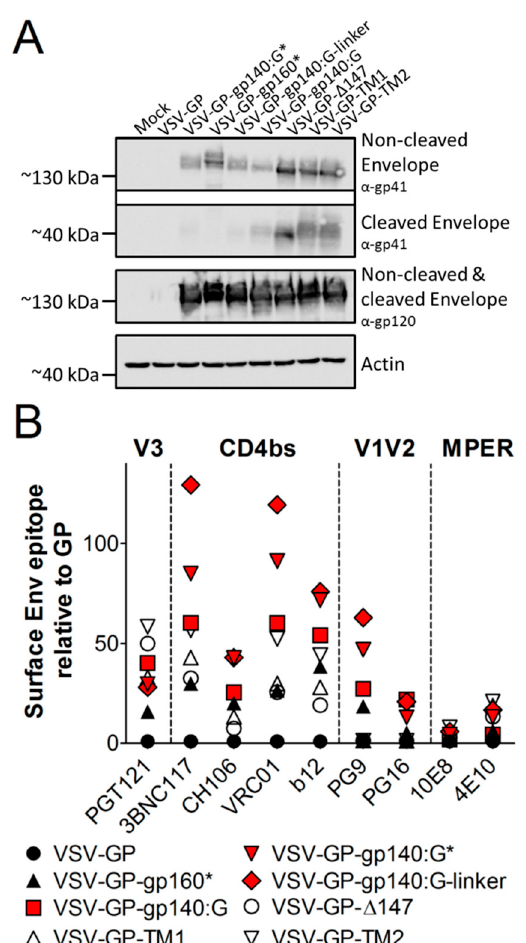
Figure 3. All HIV Env variants are expressed at comparable levels in infected BHK-21 cells. BHK-21 cells were infected with VSV-GP, VSV-GP-gp140:G*, VSV-GP-gp160*, VSV-GP-gp140:G-linker, VSV-GP-gp140:G, VSV-GP- ∆ 147, VSV-GP-TM1 and VSV-GP-TM2 with a MOI of 0.1. Twenty-four hours after infection, cell lysates were prepared for western blotting ( A ) or cells were trypsinized and analyzed by flow cytometry ( B ). As a negative control, cell lysates from non-infected BHK-21 cells (Mock) were used. ( A ) The non-cleaved HIV Env precursor protein (gp160) and the cleaved gp41 protein were detected with an anti-HIV-1 gp41 monoclonal antibody (4E10, upper two blots). The non-cleaved Env precursor and the cleaved gp120 subunit were detected on a separate membrane using an anti-HIV-1 gp120 monoclonal antibody (16H3, third blot). As a loading control, an anti-actin antibody was used (lower blot). ( B ) Cells were stained with HIV bnAbs against the V1V2 loop of gp120 (PG9, PG16), the V3 loop of gp120 (PGT121), the CD4 binding site (b12, VRC01, 3BNC117, CH106) or the MPER of gp41 (4E10) and fluorescently-labeled anti-human secondary antibodies. As a loading control, the LCMV-GP-specific WEN4 was used. The ratio of the geometric mean fluorescence of every single HIV-specific antibody relative to the geometric mean fluorescence of the LCMV-specific WEN4 was calculated. The graph shows the mean ratio of duplicate samples for each antibody and